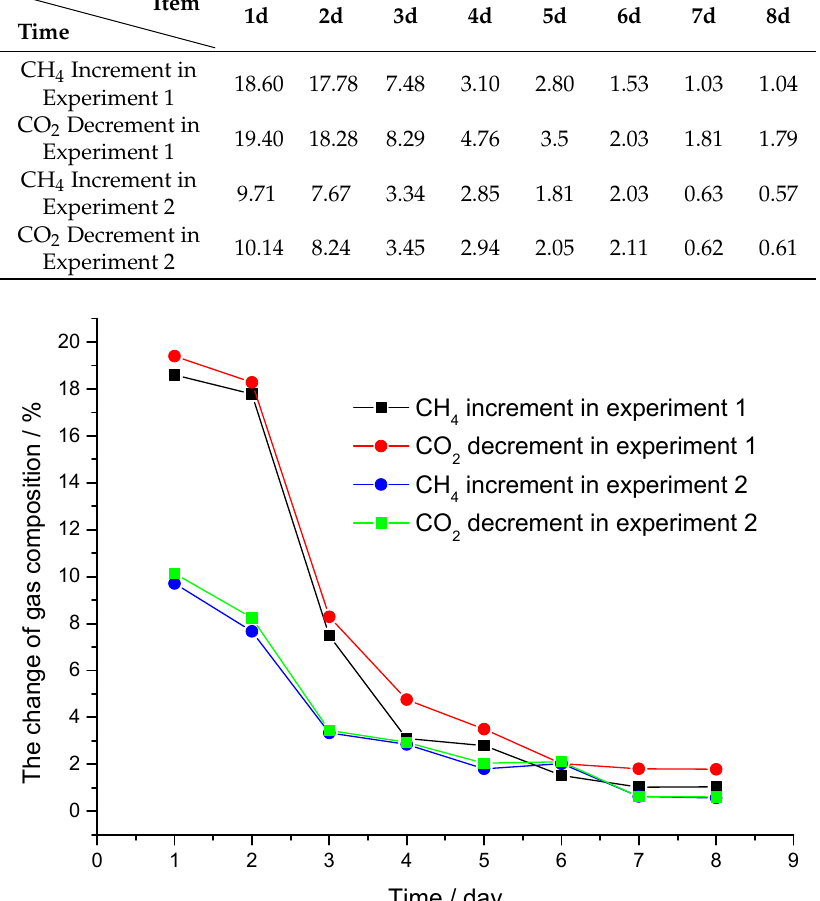
Figure 7. The increment of CH 4 fraction and the decrement of CO 2 fraction in the collected gas samples in experiment 1 and experiment 2.